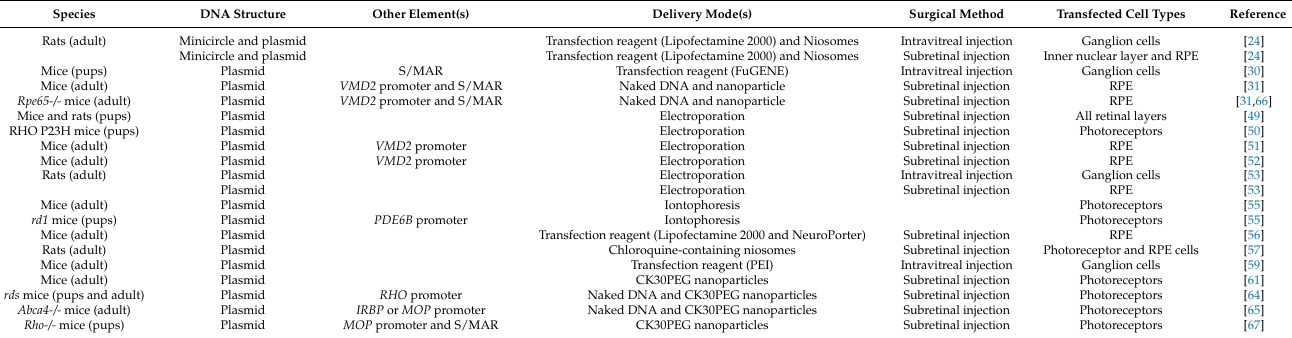
Table 1. Summary of studies investigating plasmid and minicircle delivery to the